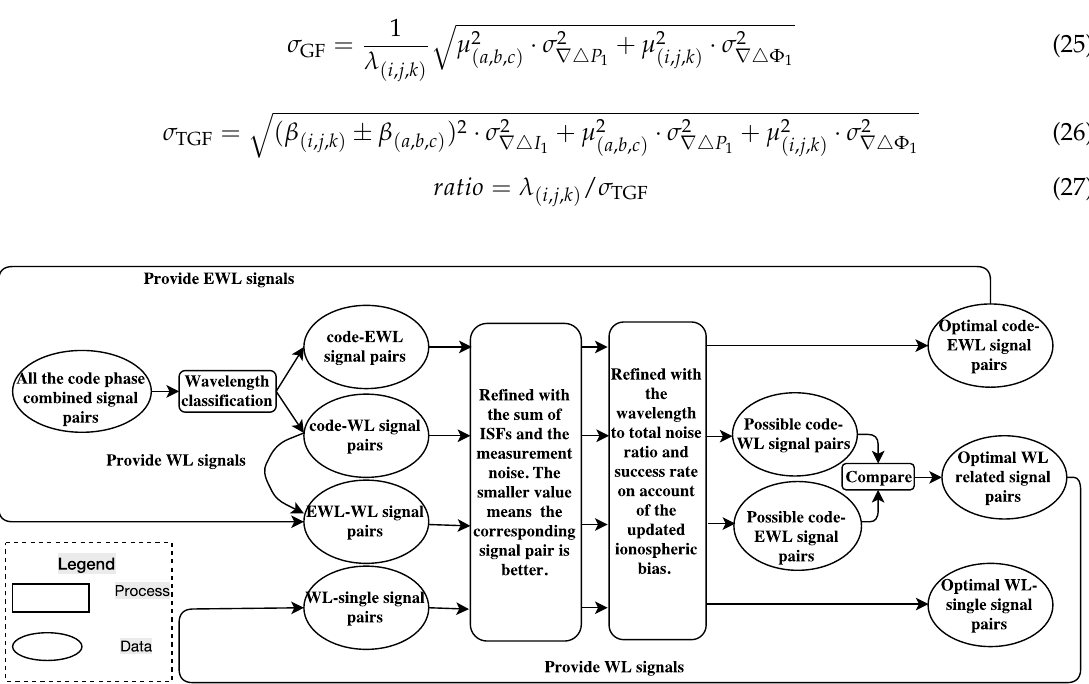
Figure 1. The procedure of selecting the optimal signal pairs for GF